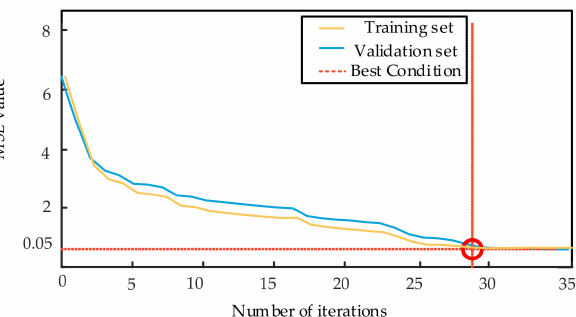
Figure 8. The change curve of MSE value during the training of the phase-selection model.